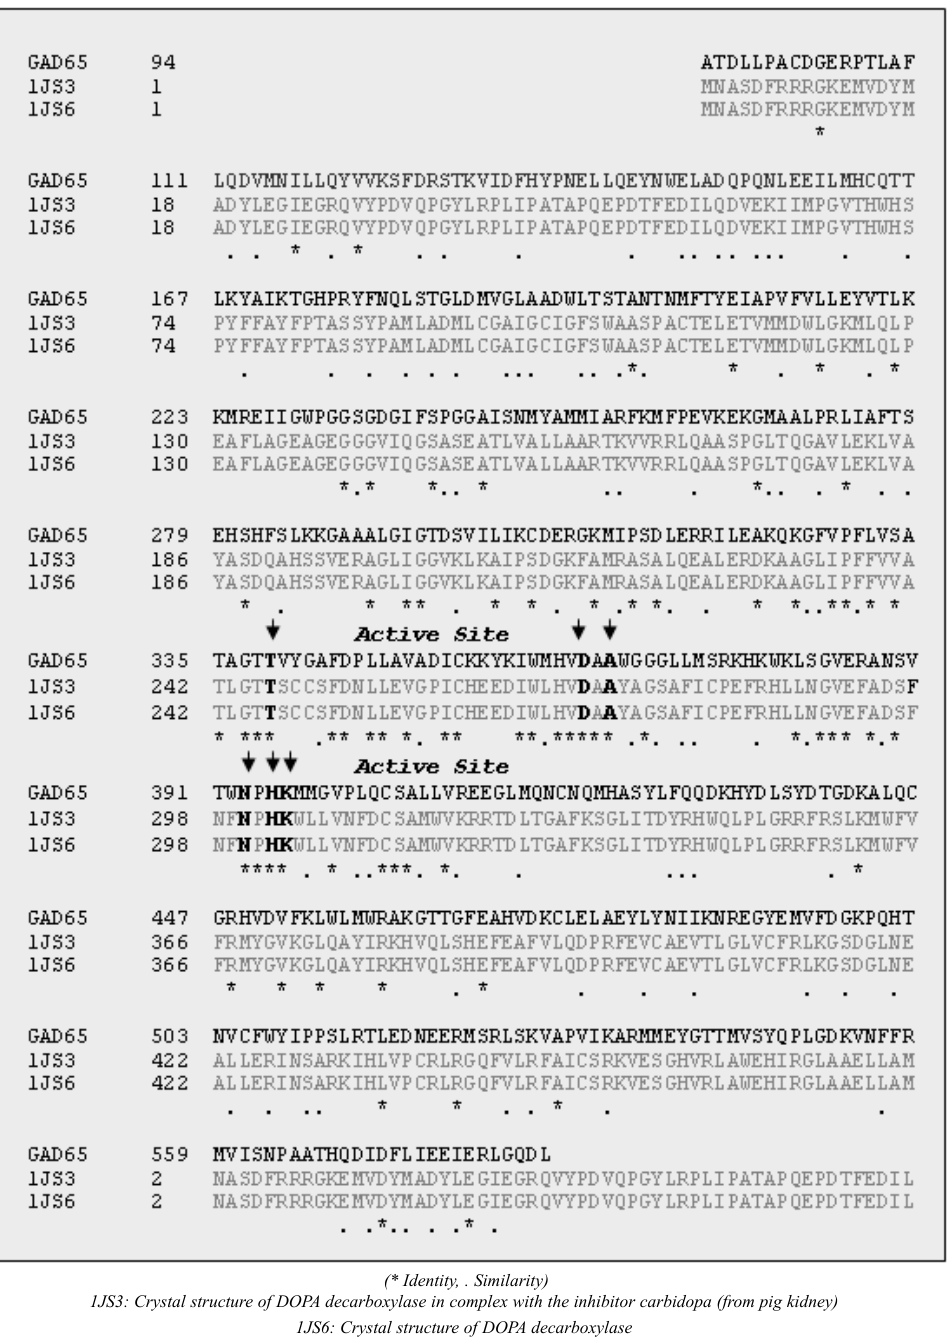
Figure 4: The necessary condition for successful homology modelling is a detectable similarity between the target sequence and the template sequence allowing the construction of a correct alignment. The alignment is used to determine the equivalent residues in the target and the template protein. The alignment of the DOPA sequence and the sequence of GAD65 shows a perfect matching between the residues of the active site of DOPA and the corresponding residues in the GAD65 sequence (the residues are keys in the alignment window) in the alignment the which can be improved by manual interventions. This curve shows how the situation for the residues alignment was then used as input for the homology changes. The curve either decreases or increases local- modelling and the structure is built up by threading the ly. Areas of weakest homology are usually loops, GAD 65 sequence into the template structures (Fig. 5).